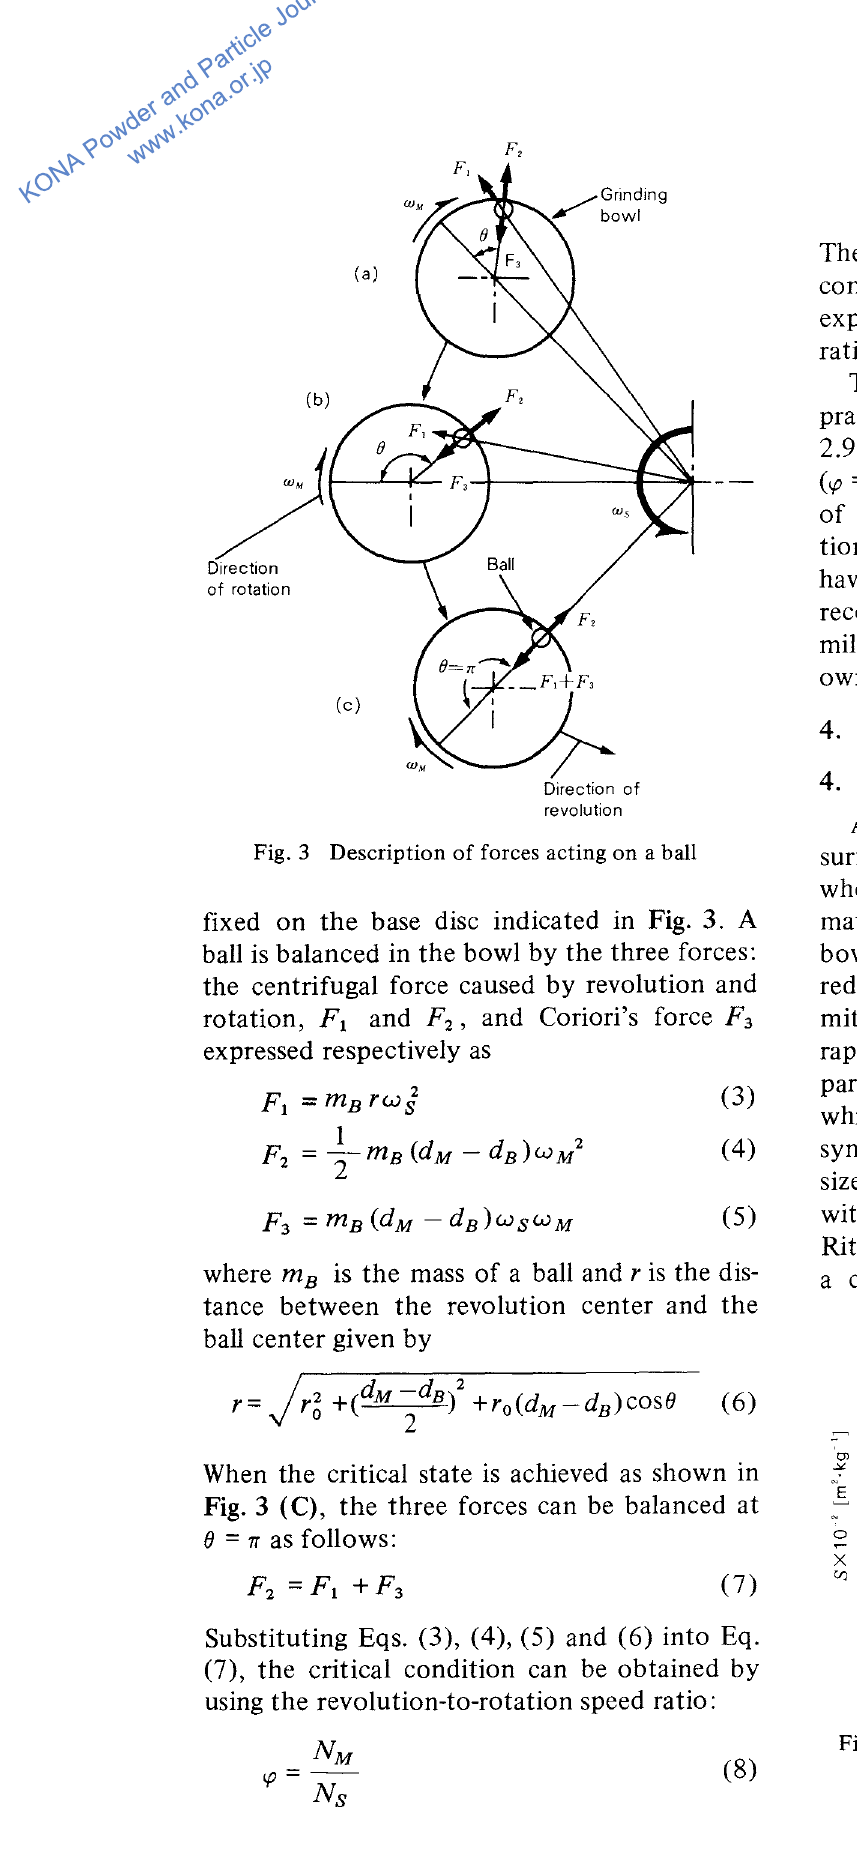
Fig. 4 Relationship between specific surface area of product and number of bowl rotations in the beginning of